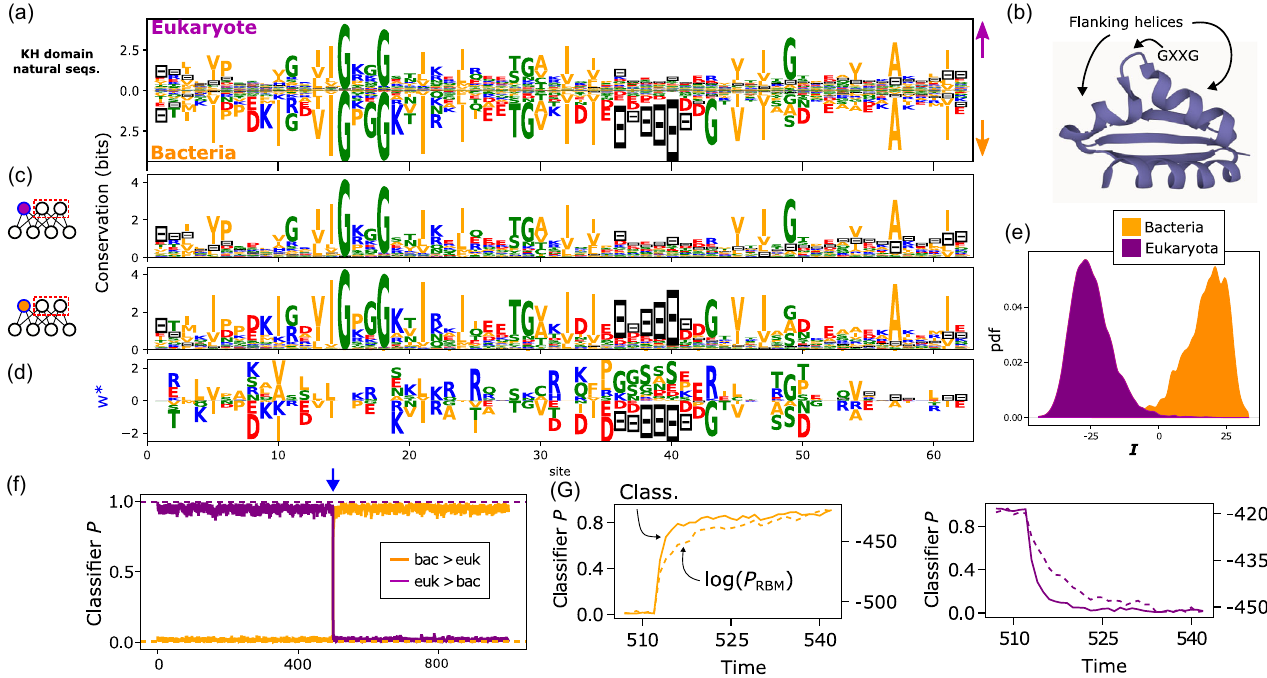
FIG. 10. Taxonomy of protein families. (a) Sequence logos of eukaryotic (purple, above) and bacterial (orange, below) sequences from the PF00013 protein family. We use the following color code: green for polar residues, blue for basic, red for acidic, and orange for hydrophobic. Gaps are shown in black. (b) Ribbon structure of KH domain showing locations of the Gly – Gly loop and flanking helices. Image prepared with Mol* Viewer [47]. (c) Sequence logos of 100 000 generated sequences when the released hidden unit is set to 1 (top) or 0 (below). To ensure that sampling is equilibrated, we track the average and standard deviation of the energy of the samples in time and see that these statistics are essentially constant after approximately 200 steps, suggesting that samples can be collected every 5000 steps. (d) Weights of the released hidden unit. (e) Inputs received by the released hidden unit when presented with sequences from the two classes. (f) Markov chain started from bacterial (orange) or eukaryotic (purple) sequences from the data. The panel shows the probability of being a eukaryotic vs bacterial sequence in a perceptron classifier. Discontinuous lines are the average value for the data sequences of each class. A total of 1024 Gibbs sampling steps are taken, and the flip of h (cid:4) occurs at step 512 (blue arrow). (g) Enlarged ˜ P v Þ ] of sampled sequences (right axis) evaluated view near the transition, showing also the log of the unnormalized marginal [log RBM ð on a RBM trained on the full